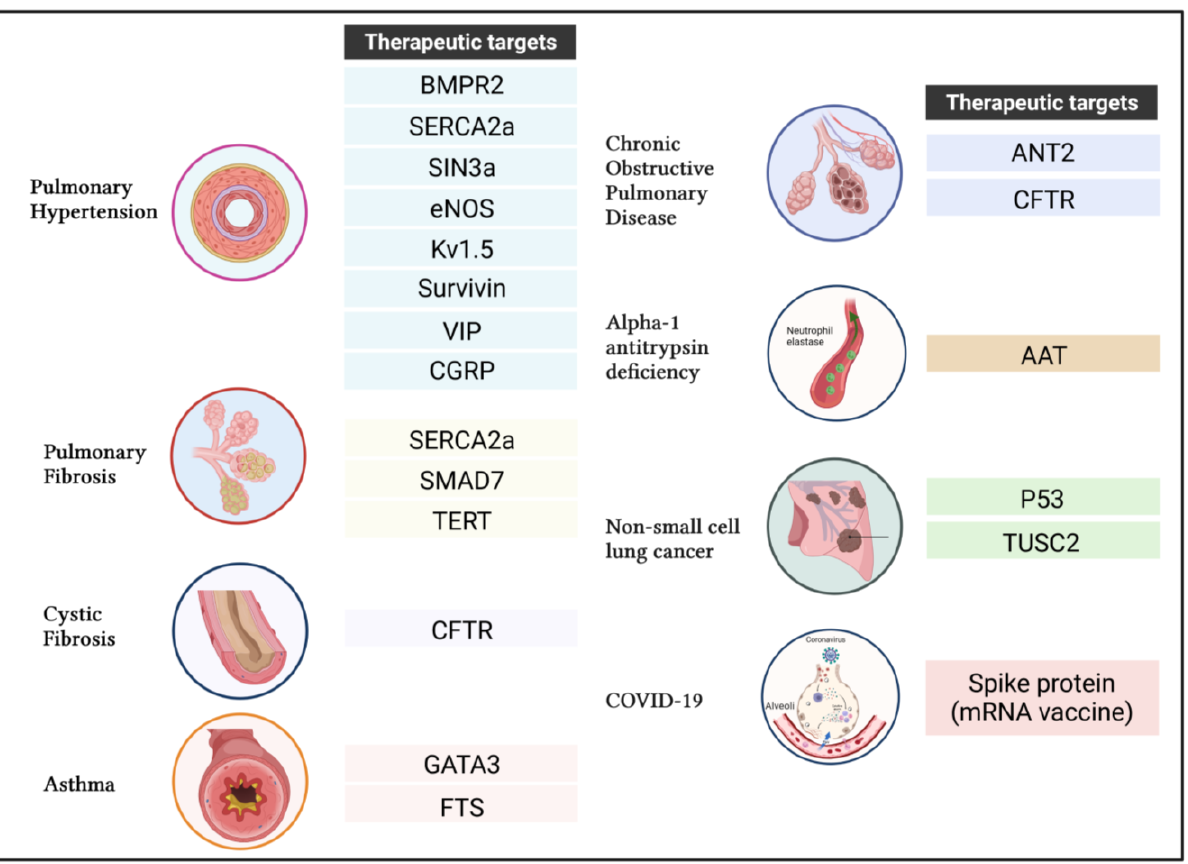
Figure 3. Main therapeutic candidates currently under investigation as lung-targeted gene